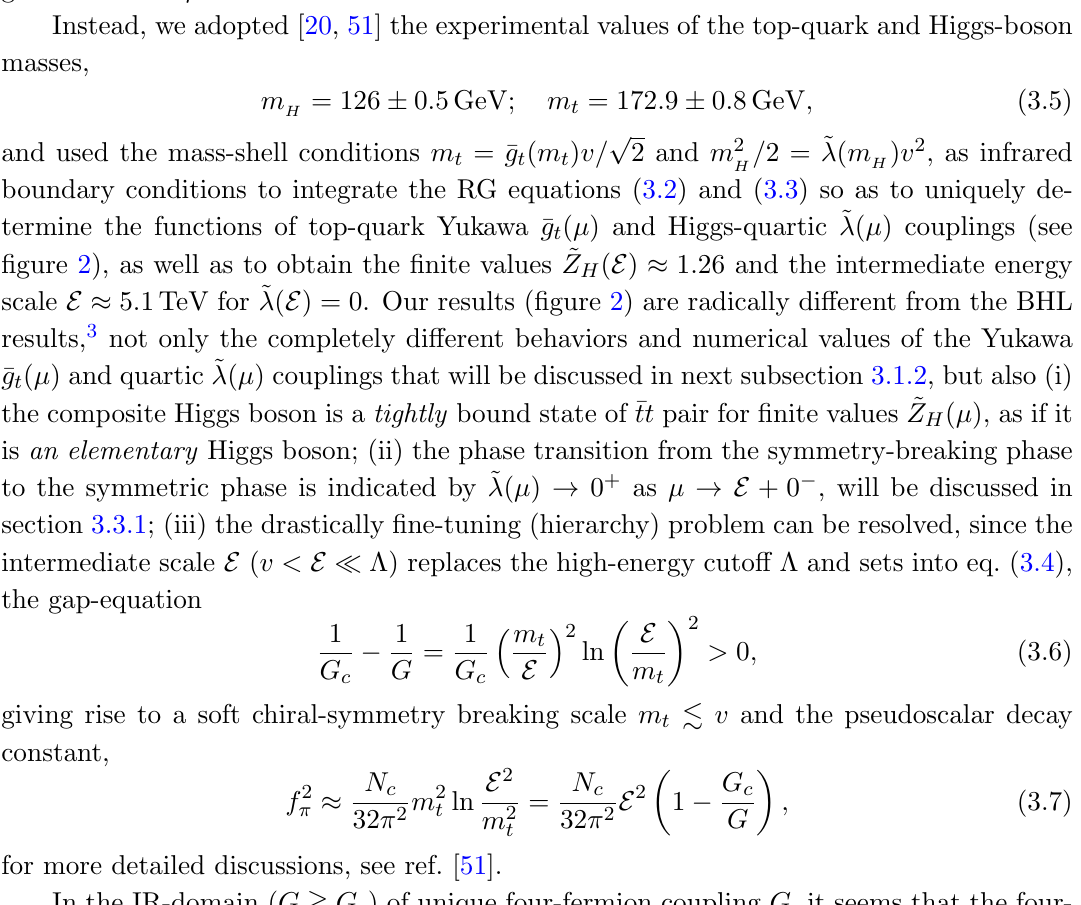
) as boundary H ) = 0 at 5 . 14 TeV and ˜ λ ( µ ) < 0 for µ > E E ≈ E